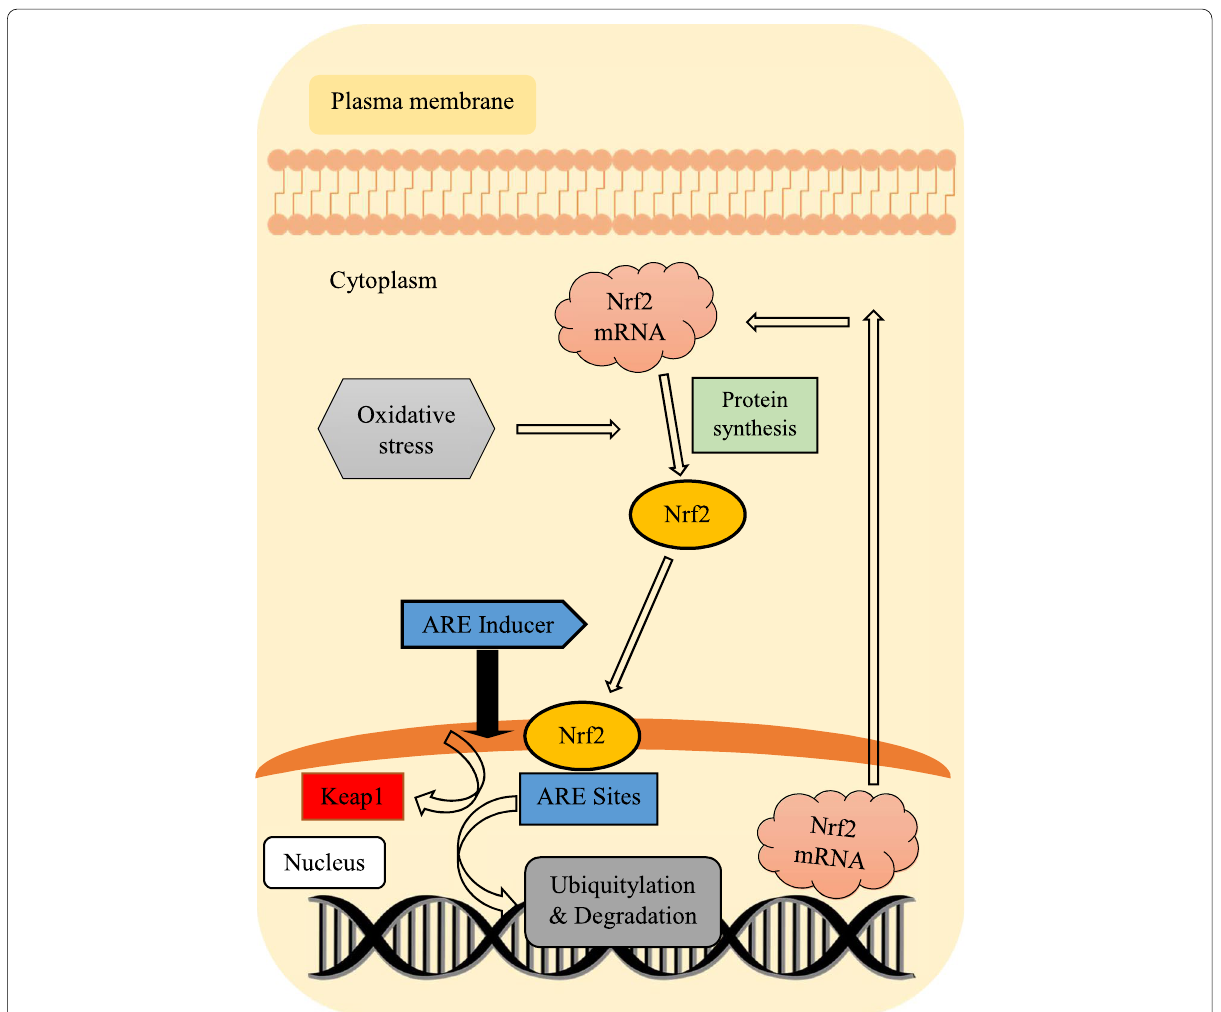
Fig. 5 Nrf2 pathway (the NFE2L2 gene encodes nrf2, transcription